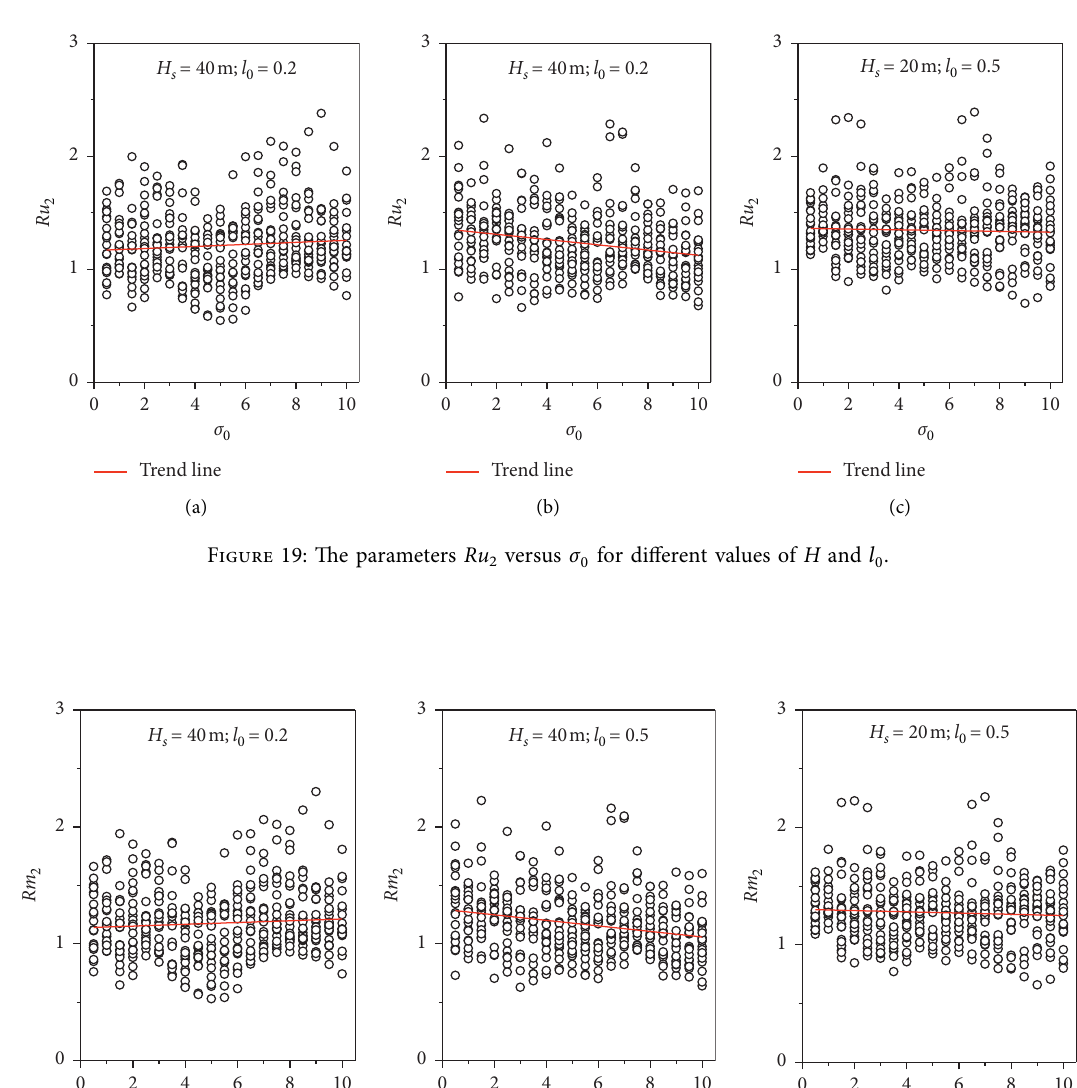
Figure 20: The parameters Rm